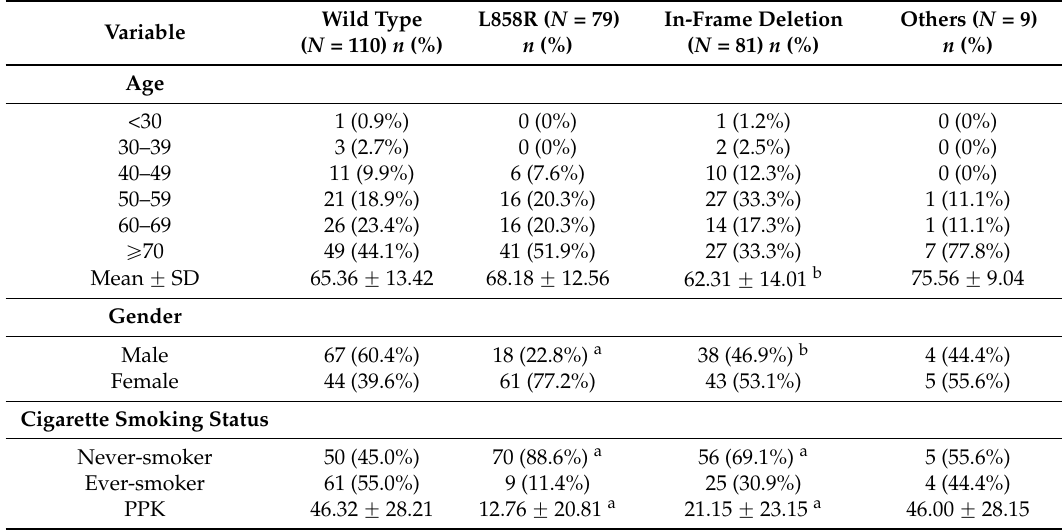
Table 3. Demographics and clinical characteristics of 279 patients in lung adenocarcinoma with epidermal growth factor receptor (EGFR) mutation